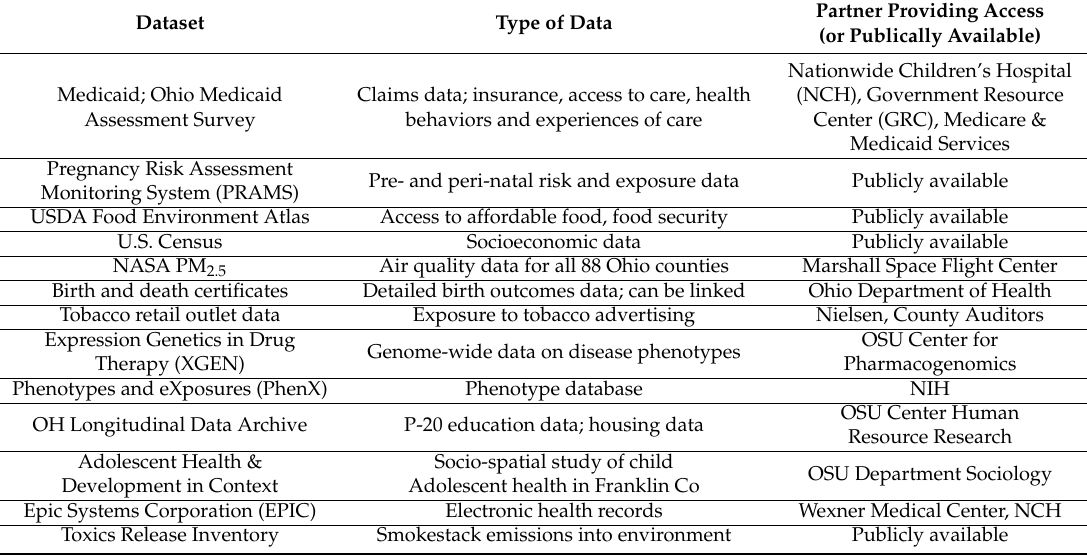
Table 1. Examples of mineable sources of environmental data (bold) that are presently included in the customized public participatory geographical information systems (PPGIS) portal for